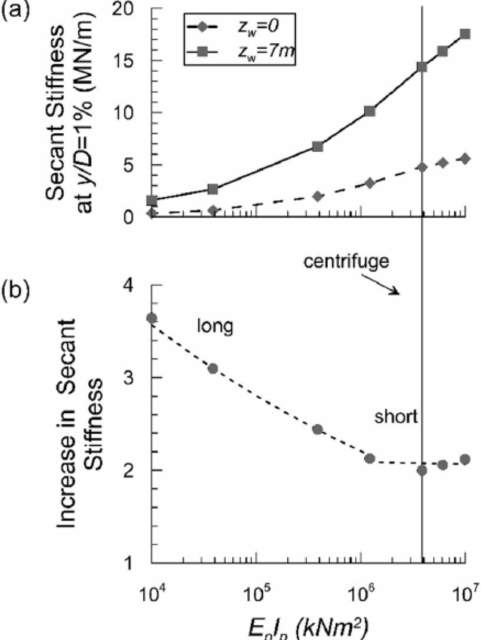
Figure 15. Secant stiffness ( a ) and increase in secant stiffness ( b ) in function of the flexural rigidity of the